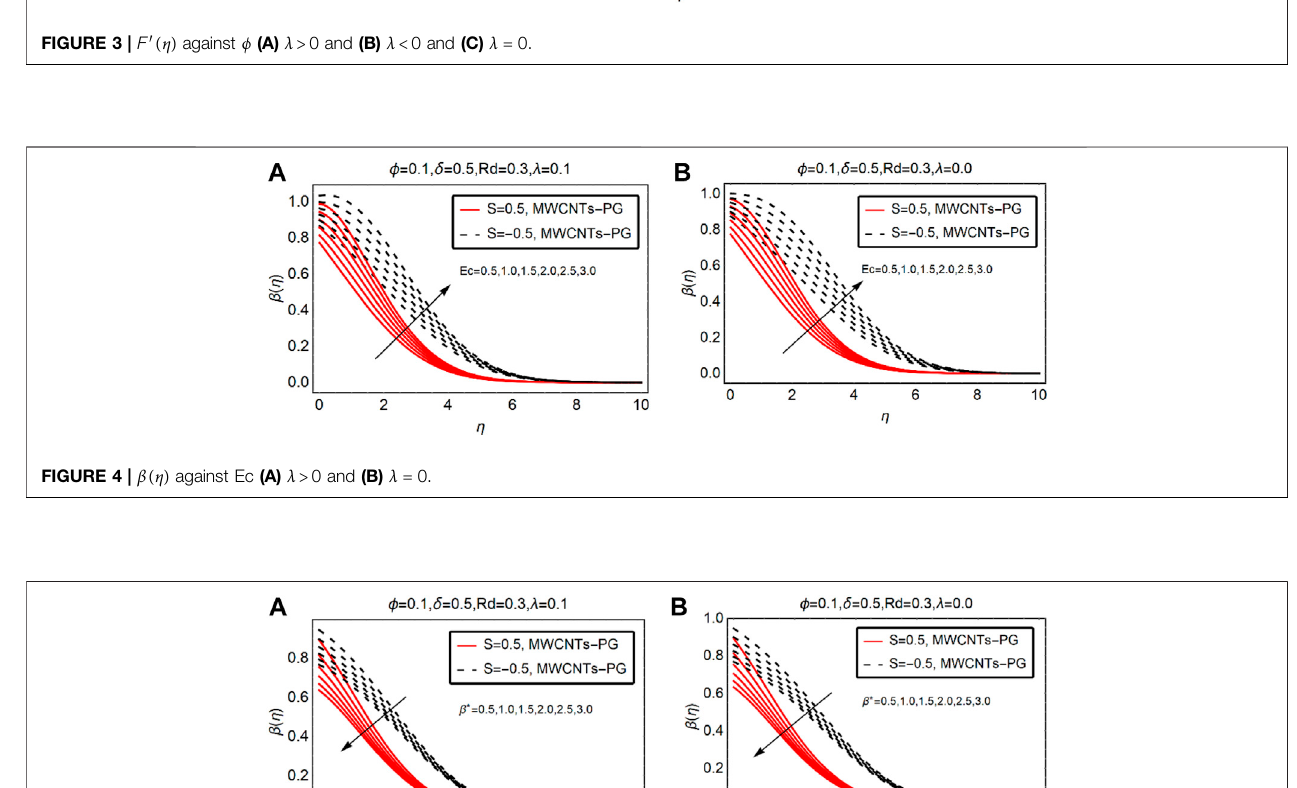
Frontiers in Chemistry |